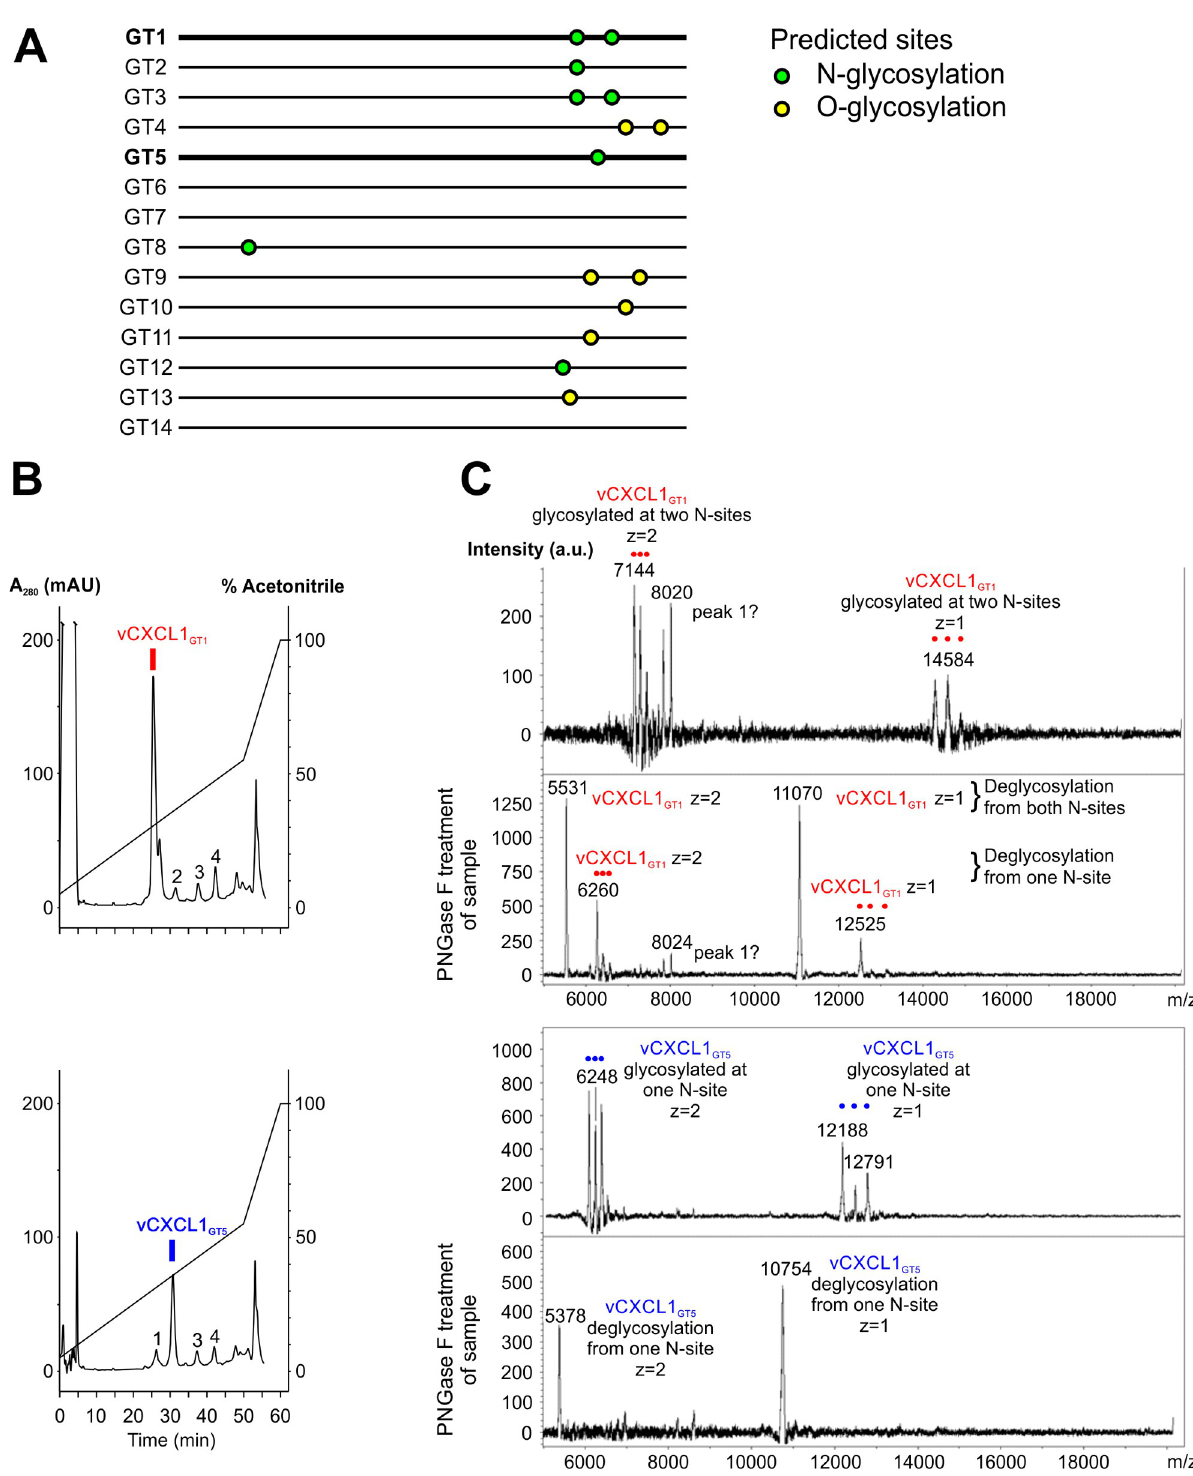
Fig 2. Purification and mass spectrometry analysis of recombinant vCXCL1 GT1 and vCXCL1 GT5 expressed in COS-7 cells. (A) Cartoon representation of predicted glycosylation sites in the 14 genotypic vCXCL1 proteins (B) HPLC elution profiles of conditioned media from eukaryotic cells transfected with UL146 GT1 (top panel) and UL146 GT5 (bottom panel). Minor background peaks are marked numerically. mAU; milliabsorbance units. (C) MALDI-TOF mass spectrometry analysis of untreated (top chromatogram) and PNGase F treated (bottom chromatogram) samples of vCXCL1 GT1 and vCXCL1 GT5 (red and blue peaks isolated in panel B).